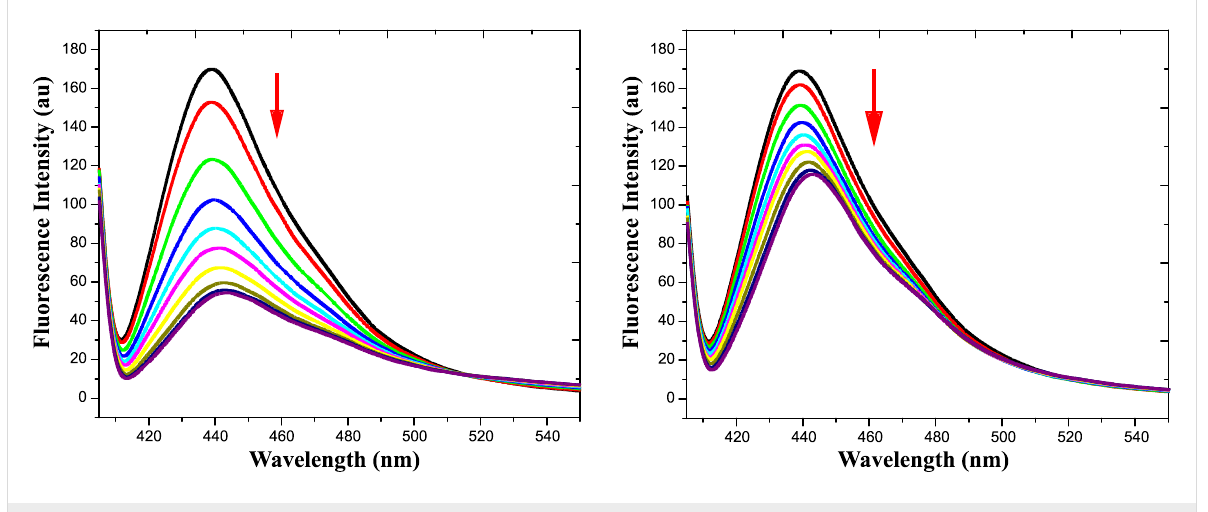
Figure 6: Fluorescence change of receptor 1 ( c = 4.475 × 10 −5 M) upon gradual addition of [Bu 4 N] + F − (left side) and [Bu 4 N] + AcO − (right side) in CH